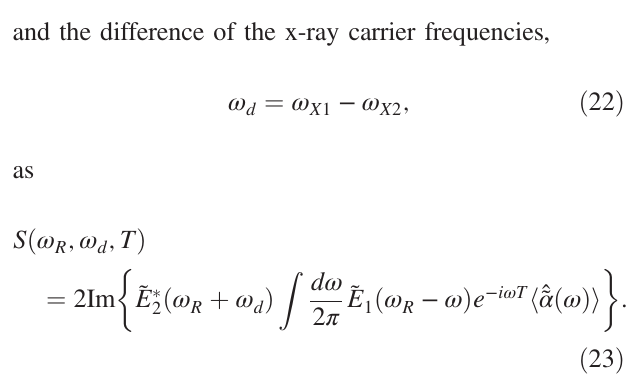
ffiffiffiffiffiffiffiffiffiffiffiffiffiffiffiffiffiffiffiffiffiffiffiffi ρ ð t Þ ρ aa